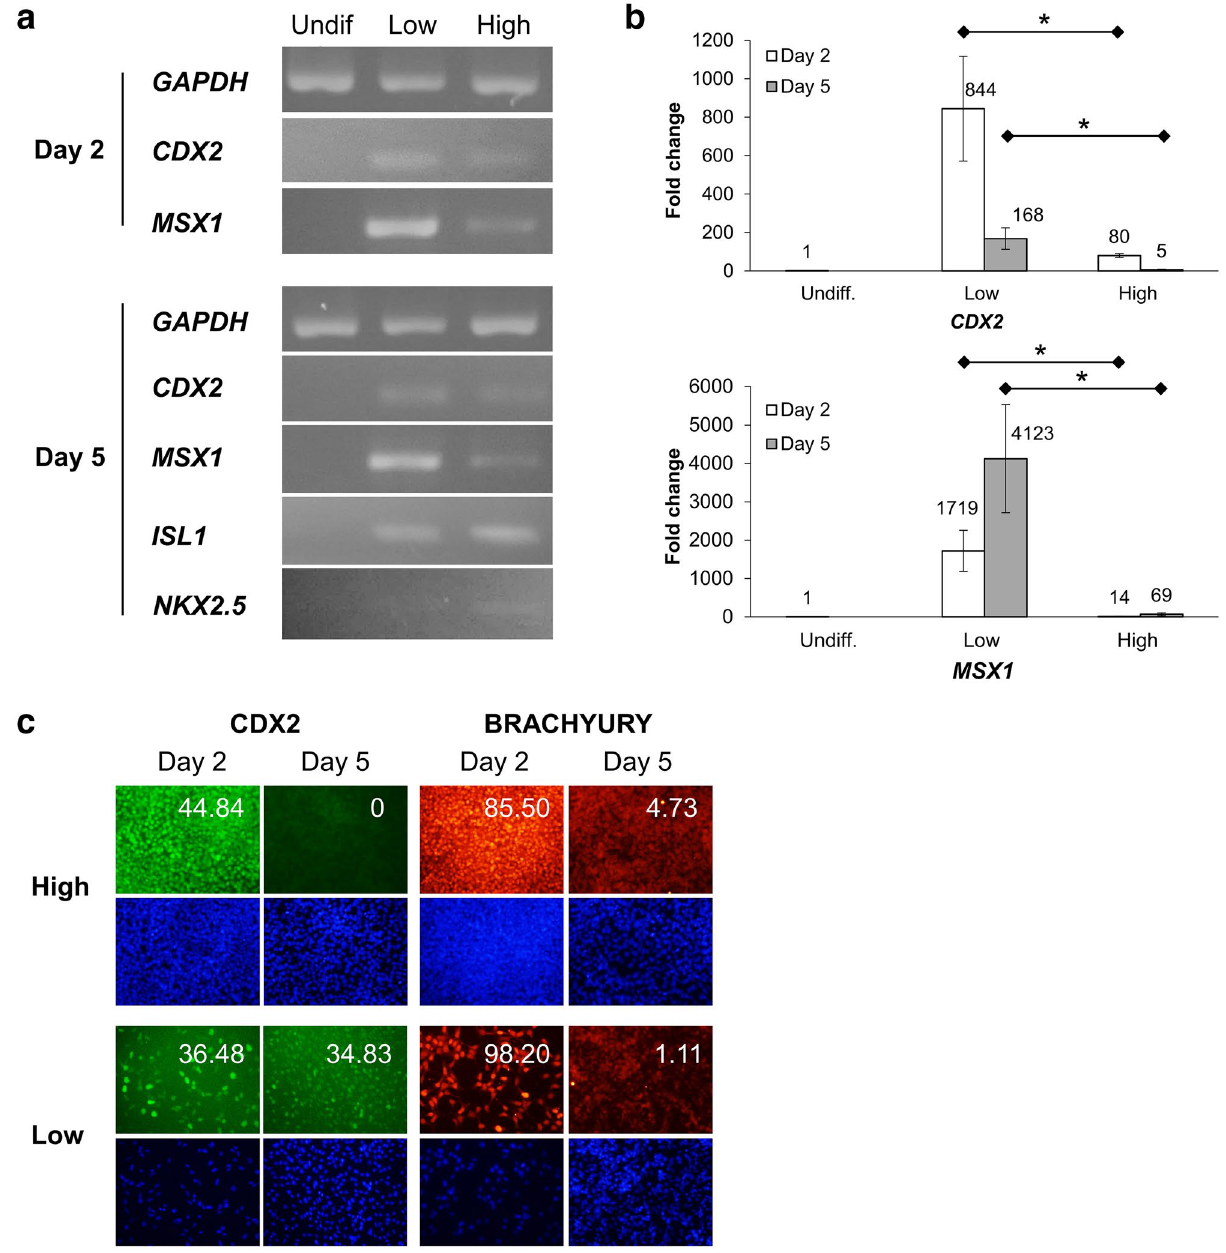
Figure 2. Cells at an initial low cell density expressed a higher level of anti-cardiac mesoderm genes, thereby inhibiting cardiac progenitor expression. ( a ) Expression of anti-cardiac ( CDX2 and MSX1 ) and cardiac progenitor genes ( ISL1 and NKX2.5 ) in undifferentiated cells and in cardiac-differentiated cells at initial low and high densities, on day 2 and 5 by RT-PCR. ( b ) Quantification of anti-cardiac gene expression ( CDX2 and MSX1 ) on day 2 and 5 by RT-qPCR, showing the fold change in comparison with their expression in undifferentiated cells. Mean ± SE, * P < 0.05, t-tests with Holm’s correction, n = 2. ( c ) Immunostaining of cardiac differentiated cells at an initial low and high cell density using CDX2 (green) and BRACHYURY (red) on day 2 and day 5. DAPI (blue) was used for positive control. At an initial low cell density, CDX2 expression was not downregulated but was maintained at high levels on day 5. The numbers indicate the expression of the corresponding markers. Scale bar = 200